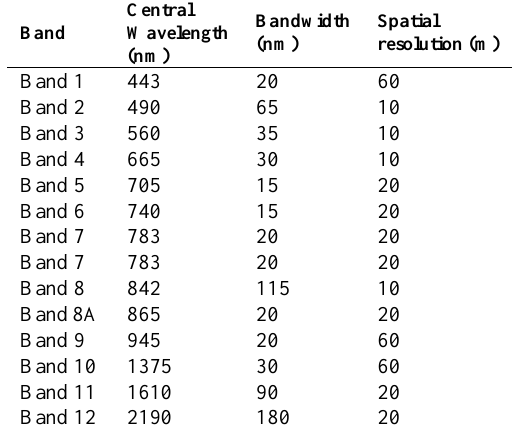
Table 1. Band description of Sentinel-2